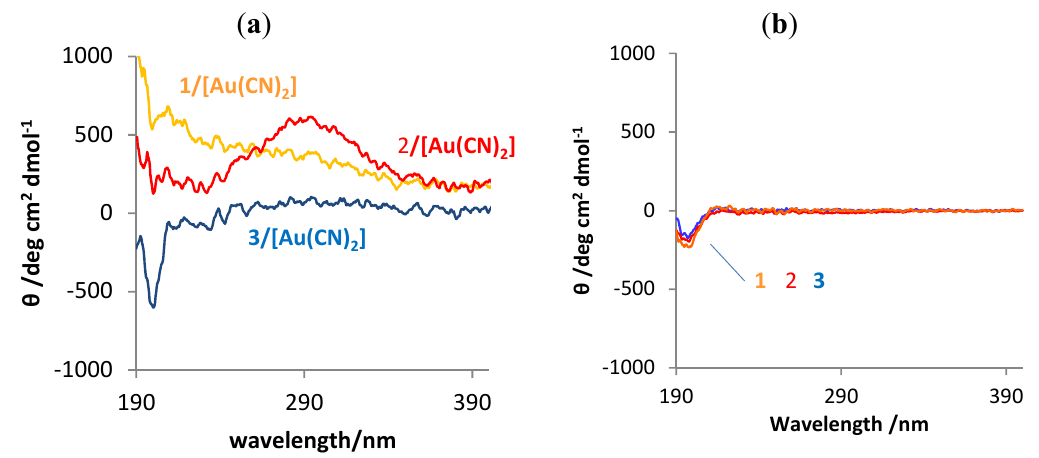
Figure 3. ( a ) Circular dichroism (CD) spectra of 1 /[Au(CN) ] − in DI water. [Au(CN) 3 /[Au(CN) 2 ( b ) CD spectra of 1 , 2 and 3 in DI water ([Lys unit] = 0.2